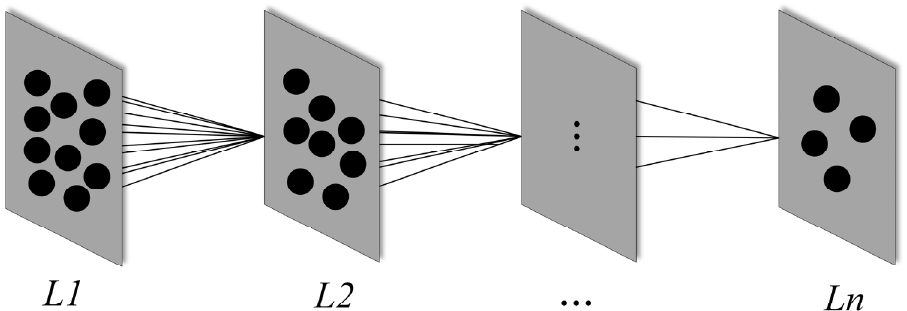
Figure 1. Flow chart of IDEM.